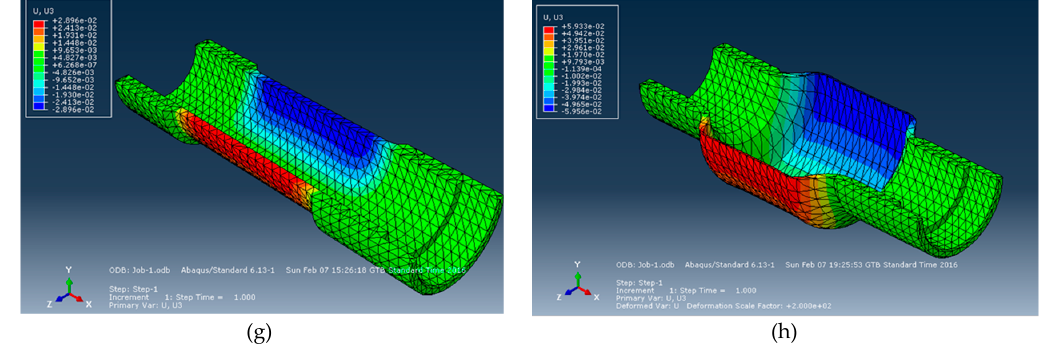
Figure 10. Stress and strain states of pipes obtained by finite element analysis (FEA): ( a ) von Mises stress in the case of a pipe with β > 1.1; ( b ) von Mises stress in the case of a pipe with β < 1.1; ( c ) displacement in the longitudinal direction (U x ) in the case of a pipe with β > 1.1; ( d ) displacement in the longitudinal direction (U x ) in the case of pipe with β < 1.1; ( e ) displacement in the y direction (U y ) in the case of a pipe with β > 1.1; ( f ) displacement in the y direction (U y ) in the case of a pipe with β < 1.1; ( g ) displacement in the z direction (U z ) in the case of a pipe with β > 1.1; ( h ) displacement in the z direction (U z ) in the case of a pipe with β < 1.1.